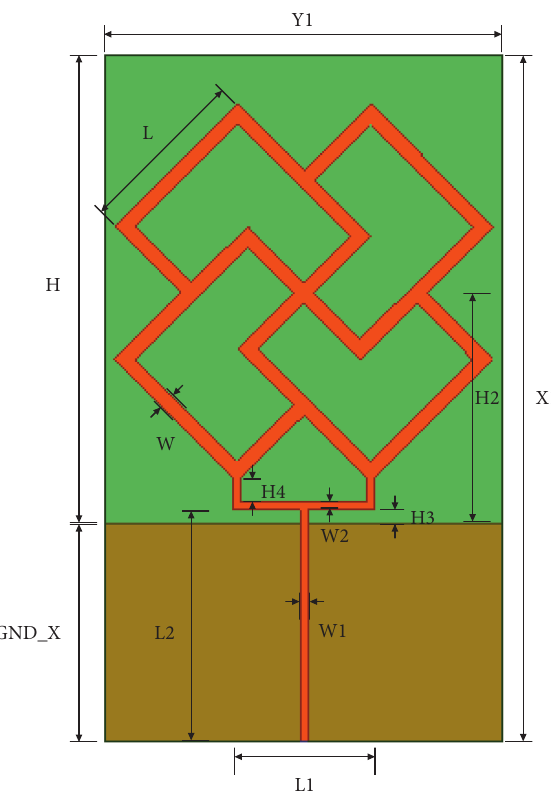
Figure 3: Imitating the classical window grille cross-structure antenna model structure.